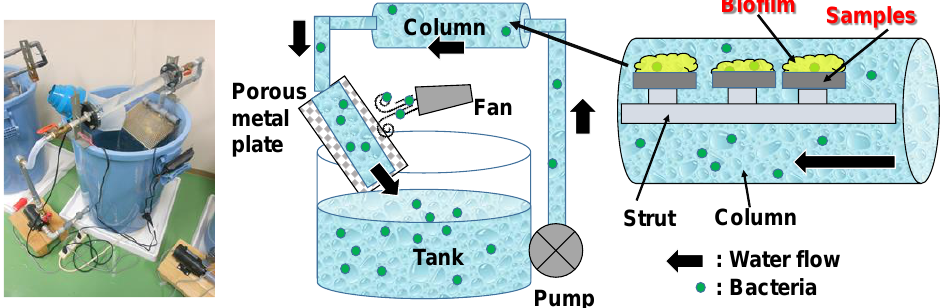
Figure 2. Schematic of the biofilm reactor.